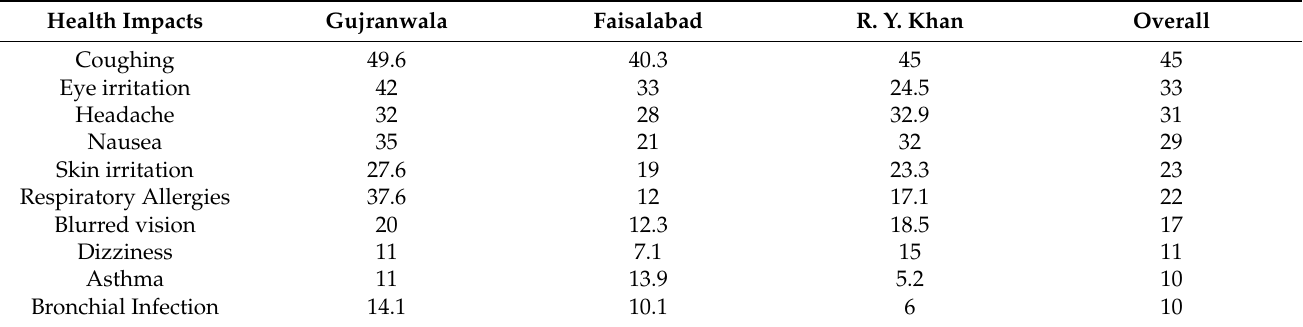
Table 2. Health damages due to crop residue burning (percentage response of respondents).